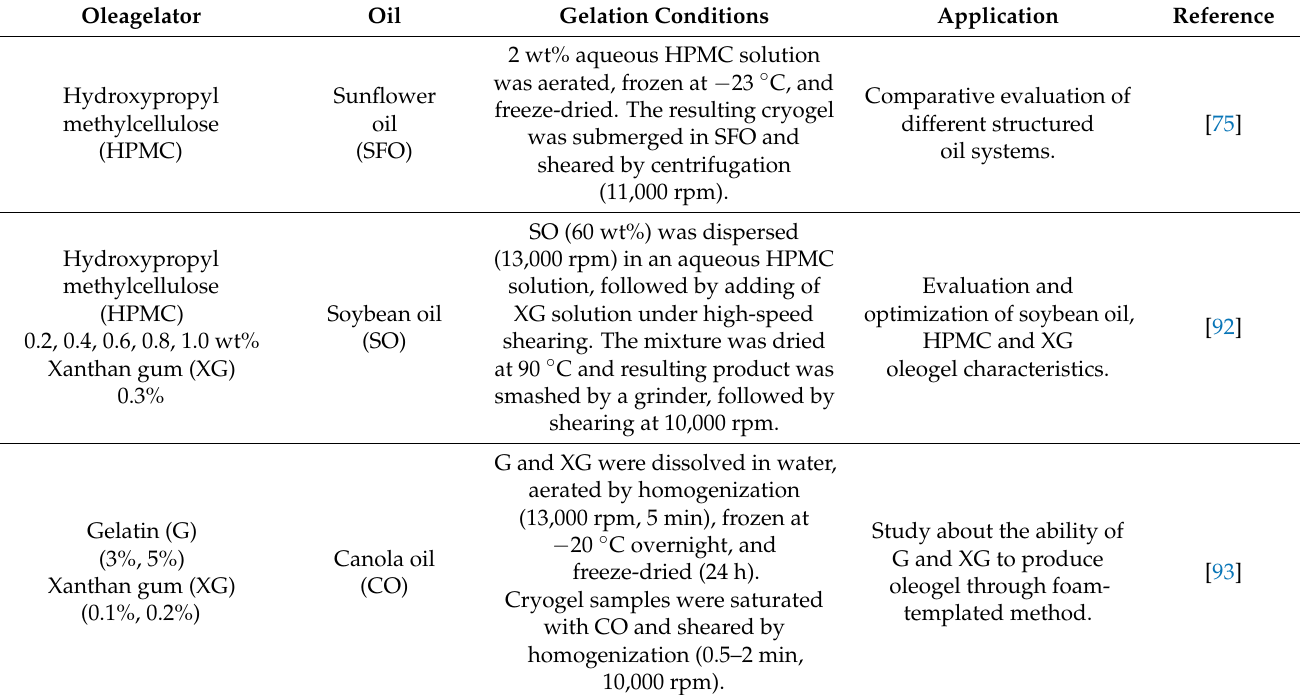
Table 2. Examples of oleogels obtained by indirect